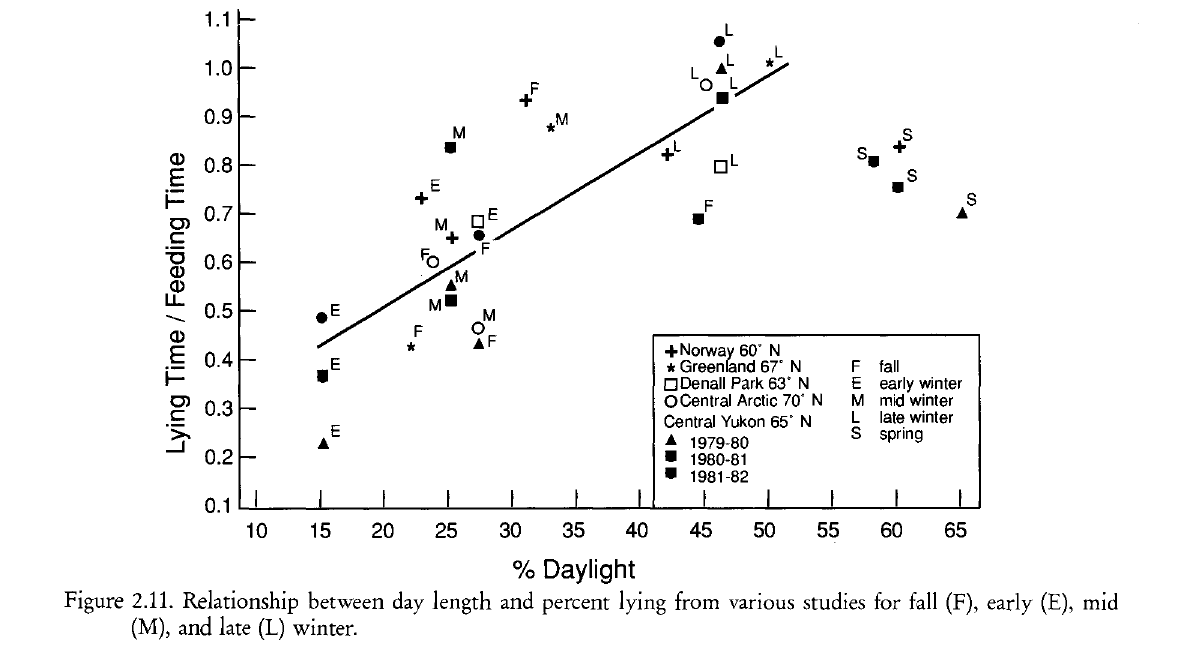
Figure 2.11. Relationship between day length and percent lying from various studies for fall (F), early (E), mid (M), and late (L)